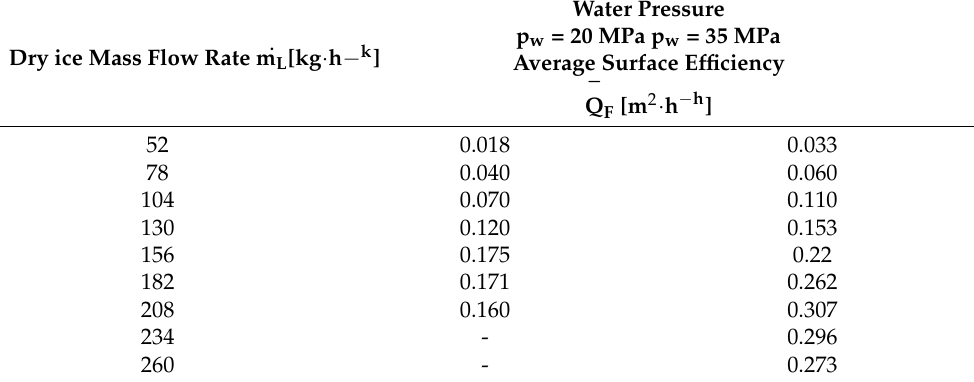
Table 14. Measuring results of average surface paint coat stripping efficiency Q F [m 2 · h − 1 ] from the surface of